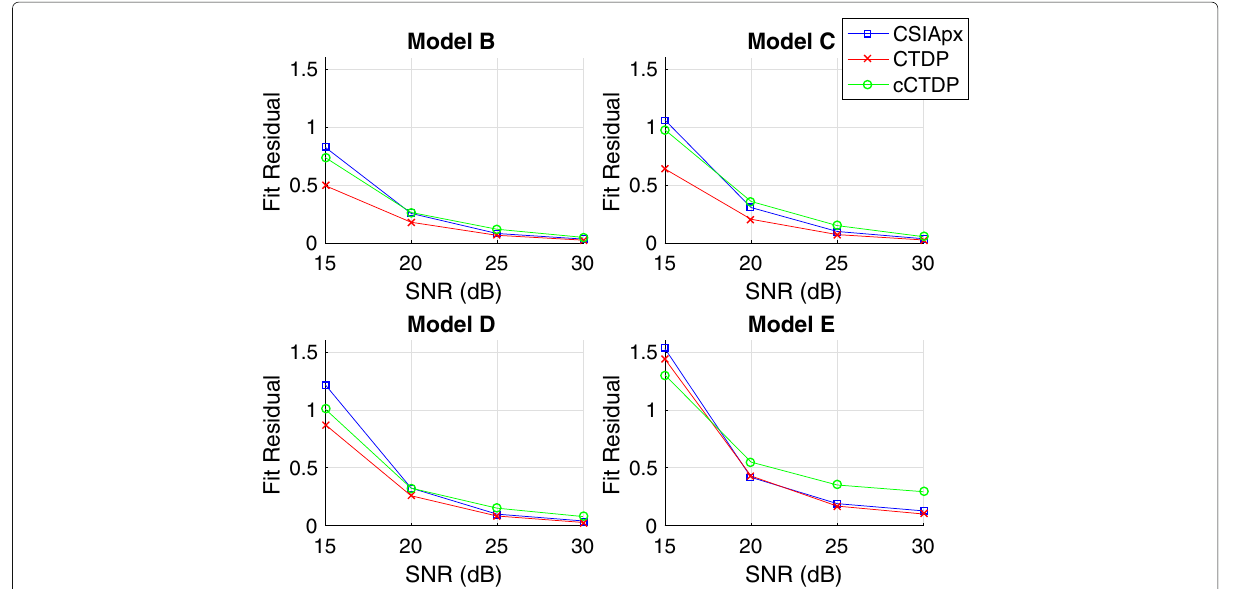
Fig. 9 Fit residual with model data. The mean of the fit residual per point is shown when running CSIApx versus CTDP versus CCTDP on the synthesized CSI data across four channel models B, C, D, and E and four SNR values 15 dB, 20 dB, 25 dB, and 30